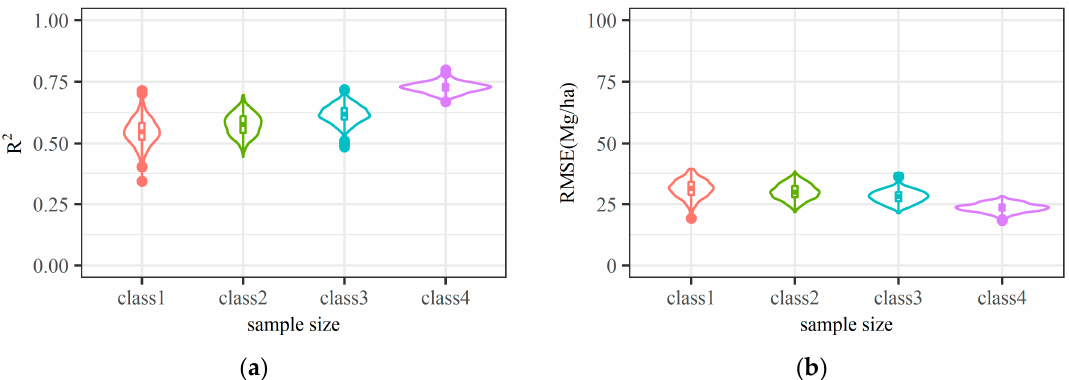
Figure 6. Modeling accuracy results from random forest (RF) AGB models with different sample size (class1 = n /4, class2 = n /3, class3 = n /2, class4 = n , n = 801) for ( a ) R 2 and ( b ) RMSE.